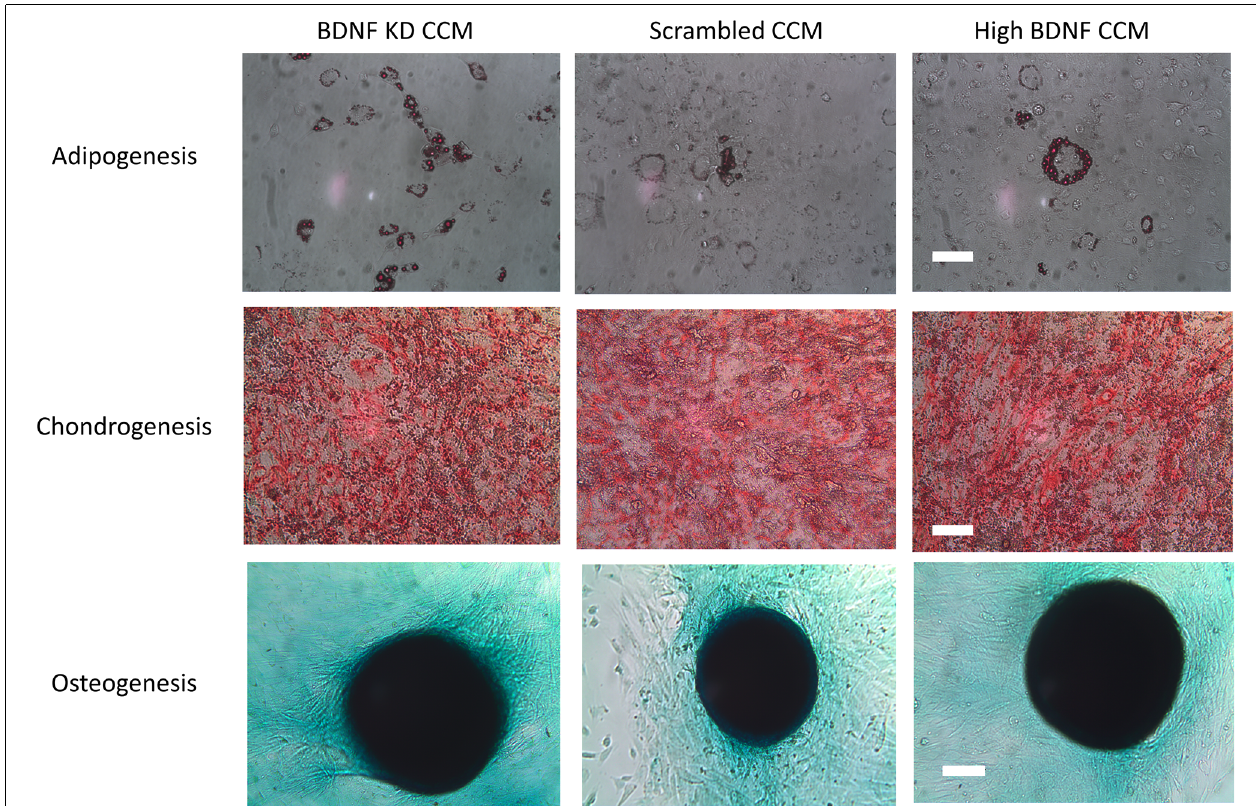
FIGURE 2 | Differentiation assay. Example images of adipogenesis, chondrogenesis, and osteogenesis assays for mesenchymal stem cells (MSCs) that were either transduced with scrambled or brain-derived neurotrophin factor (BDNF) knockdown (KD) shRNA or were nontransduced controls with high BDNF levels. The scale bars for the adipogenesis and chondrogenesis assays are 100 µ m. The scale bar for the osteogenesis assay is 500 µ